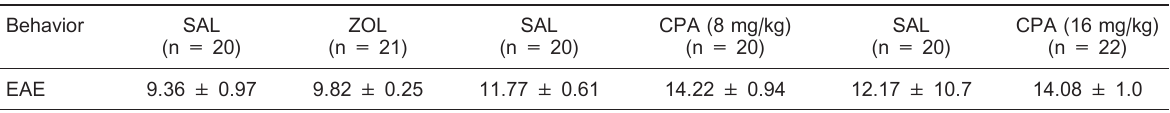
Table 1. Effects of systemic treatment with zolantidine (ZOL) or chlorpheniramine (CPA) prior to Trial 1 on behavioral measures in mice exposed to elevated plus-maze testing. Behaviors